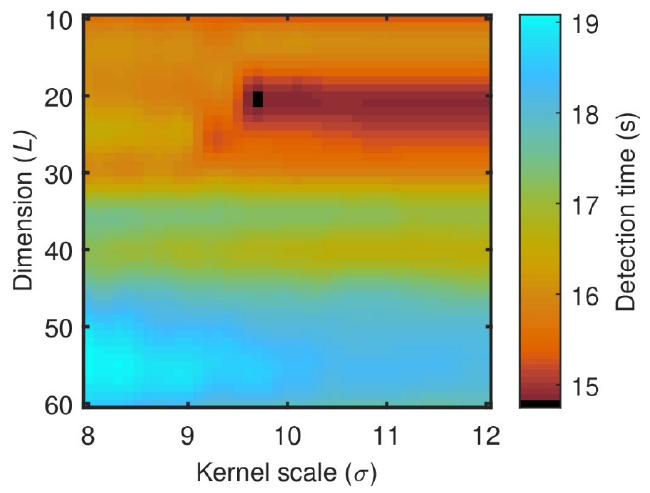
Figure 12. Variation of the average detection time for determining the optimal L and σ with real data. The minimum time of 14.75 s occurs when σ = 9.6 and L = 20.